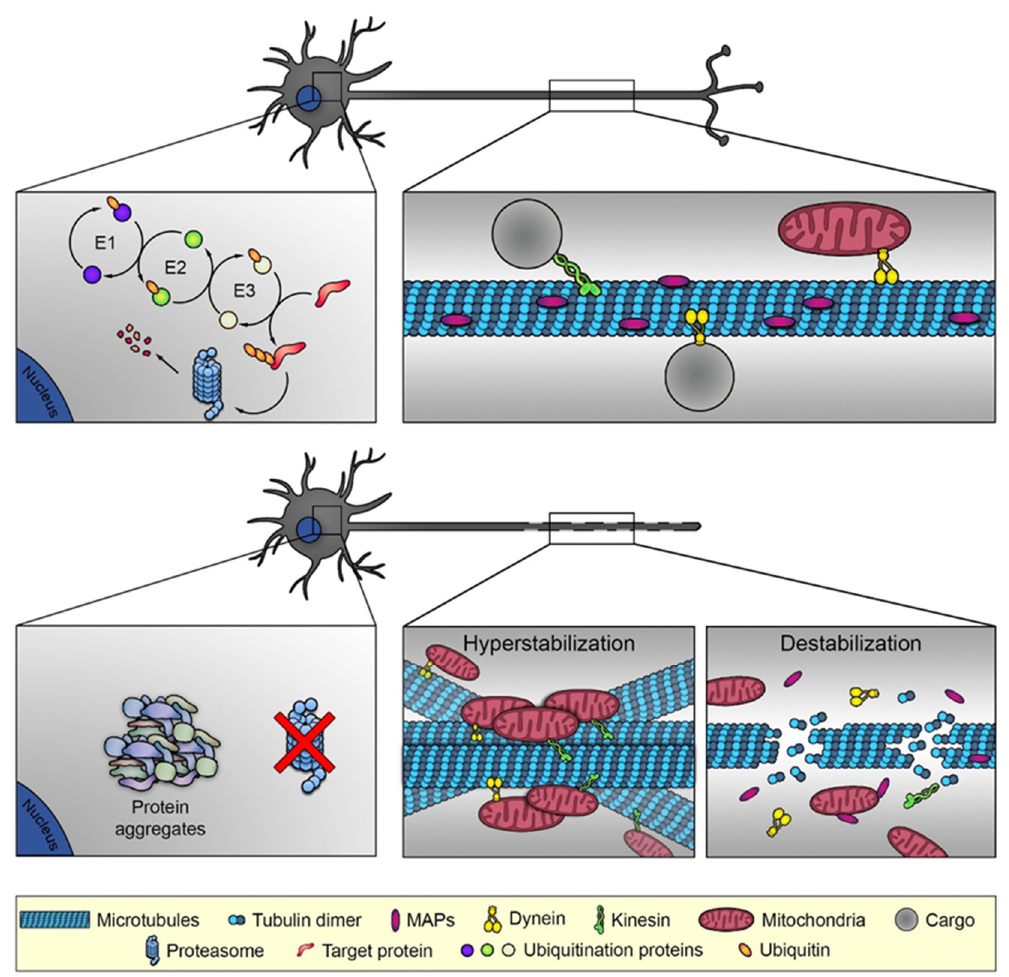
Figure 2. In healthy neurons ( upper panel ), ubiquitin-proteasome system is fully active and degrades the unfolded proteins. Not only, the microtubule organization is conventional, as depicted in Figure 1, and sustains the microtubule-dependent functions as the axonal transport of mitochondria or other cargos. In damaged neurons ( lower panel ), the ubiquitin-proteasome system is blocked, promoting the accumulation of misfolded proteins that induce aggregation, toxicity and axonal degeneration. Microtubule-dependent axonal destruction may be derived from two different conditions: microtubule hyperstabilization, which induces microtubule bundling and block of axonal transport, and microtubule destabilization, with consequent release of microtubule interacting proteins and the dismantling of the railways for intracellular trafficking.